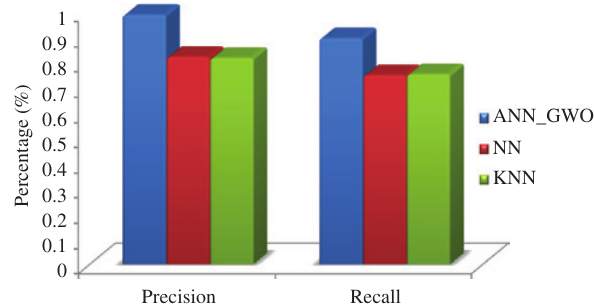
Figure 7: Precision and Recall Comparison for Different Classifiers.